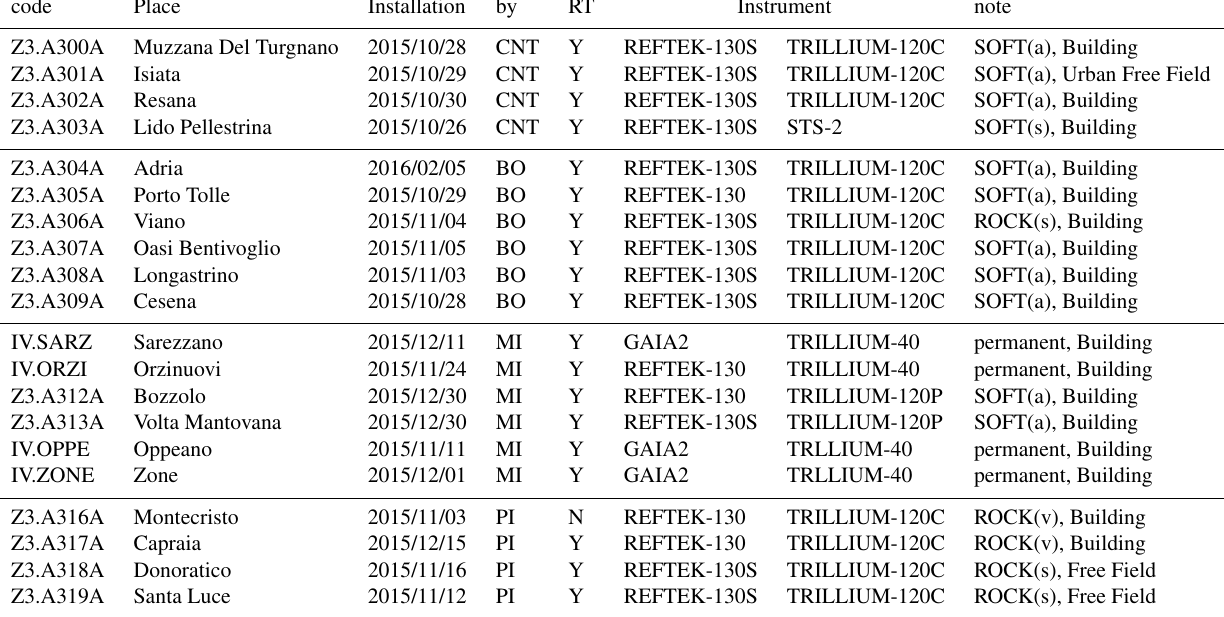
Table 1. The INGV Z3 network deployment status in Italy (July 2016). 4 of temporary planned sites were close to accelerometric sites and are now part of the National Seismic Network IV. Four sub-teams (PI, BO, MI, CNT) are responsible for the different geographical sectors: Tuscany and islands (PI), Emilia-Romagna and SE Veneto (BO), Lombardia and neighboring sites (MI), Veneto and Friuli Venezia–Giulia (CNT). Last column specifies the soil type: SOFT (a – alluvial, s – sand); ROCK (s – sedimentary, v – volcanic). code